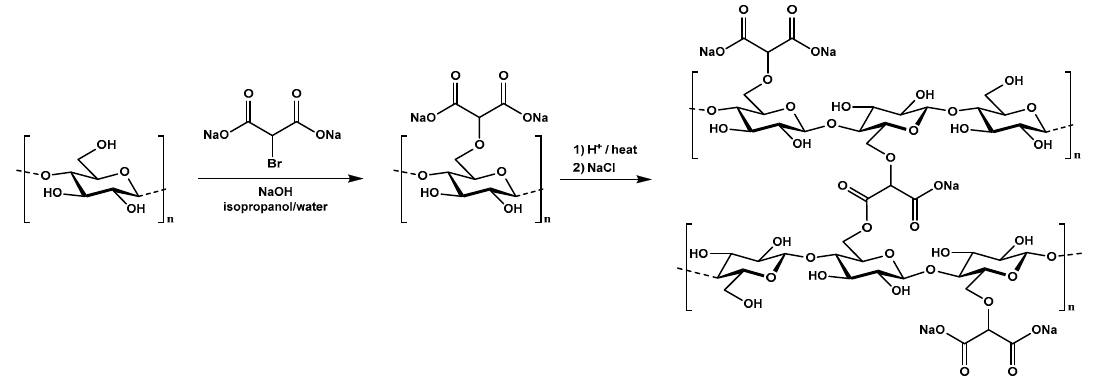
Figure 1. Schematic representation of the polymer synthesis including the heterogeneous grafting of the malonic moiety in the cellulose backbone [14] and crosslinking by intra/intermolecular esterification [13].